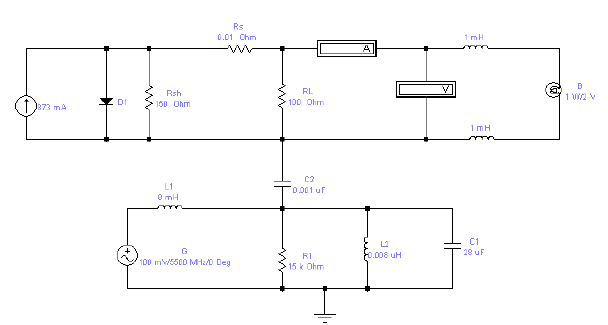
Figure2.Combined equivalent circuit of solar cell and microstrip antenna